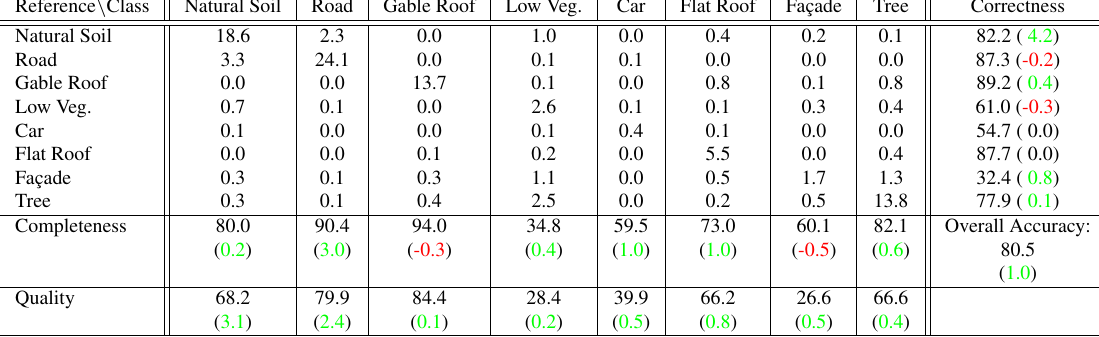
Table 1. Confusion matrix of CRF S for the three test sites in [%]. The comparison to CRF P is shown in brackets. Values in green correspond to a better result of CRF S .